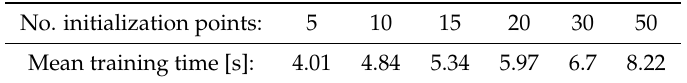
Table 1. The mean training time [s] of the KSVM with an adaptive GRBF versus the number of initialization points in the NM